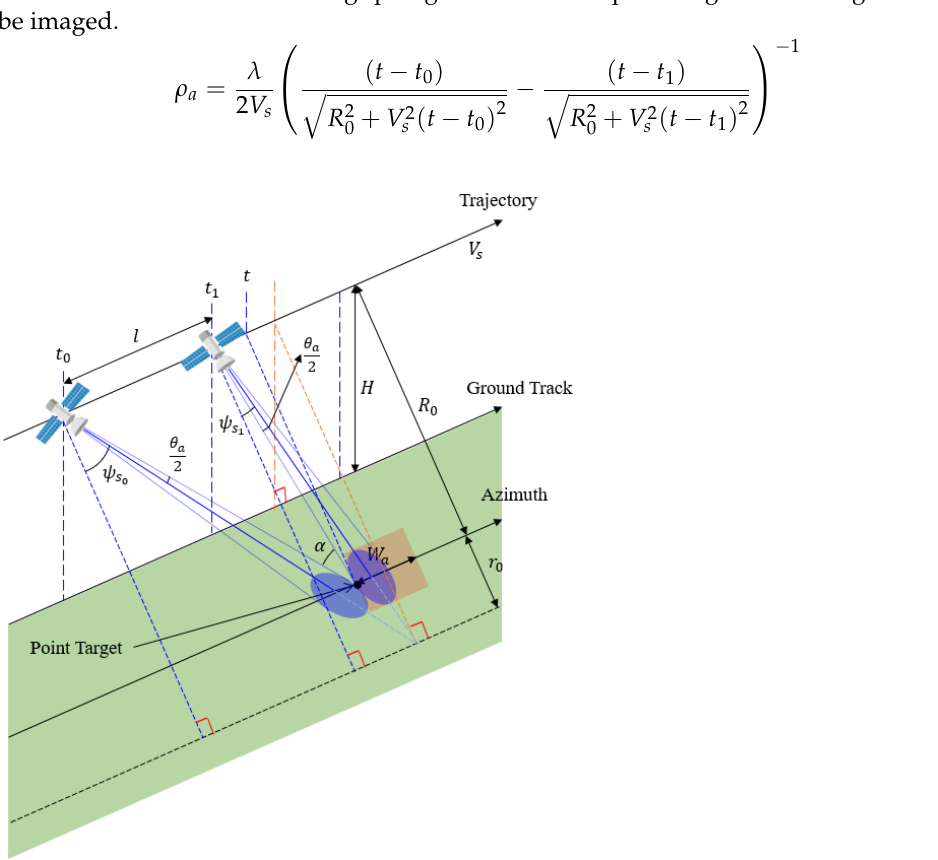
Figure 6. Image-taking geometry of a point target within target scene for broadside sliding spotlight SAR.